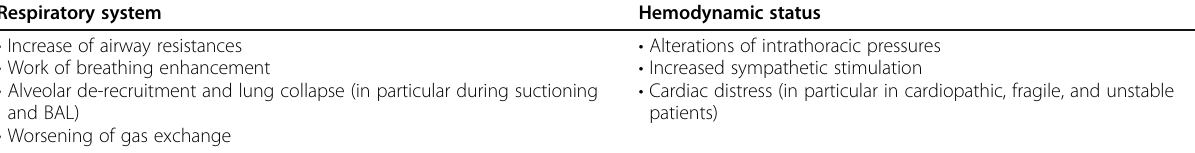
Table 1 Cardio-respiratory effects of flexible bronchoscopy Respiratory system Hemodynamic